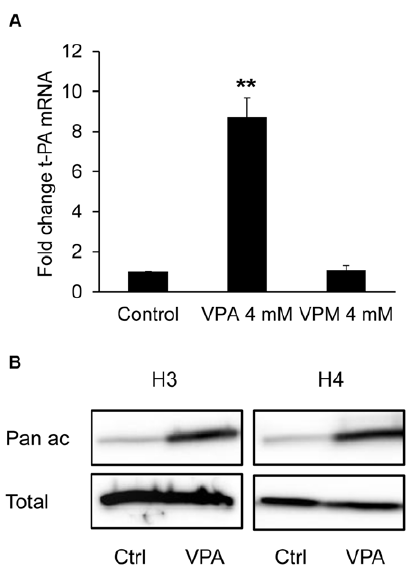
Figure 2. Dependence of HDAC-inhibitory activity for t-PA induction and effect of VPA on global histone acetylation. A. t- PA mRNA expression in HUVECs stimulated with 4 mM VPA or 4 mM VPM (a structural amide analogue of VPA which is reported to lack HDAC inhibitory activity) for 24 h. The results are presented as mean values 6 SEM of five independent experiments performed in duplicate. **p , 0.01. B. HUVECs were exposed to 3 mM VPA for 24 h after which cells were harvested in Laemmli sample buffer for analysis of global acetylation of histone H3 and H4 by Western blotting. Data are representative of three independent experiments.